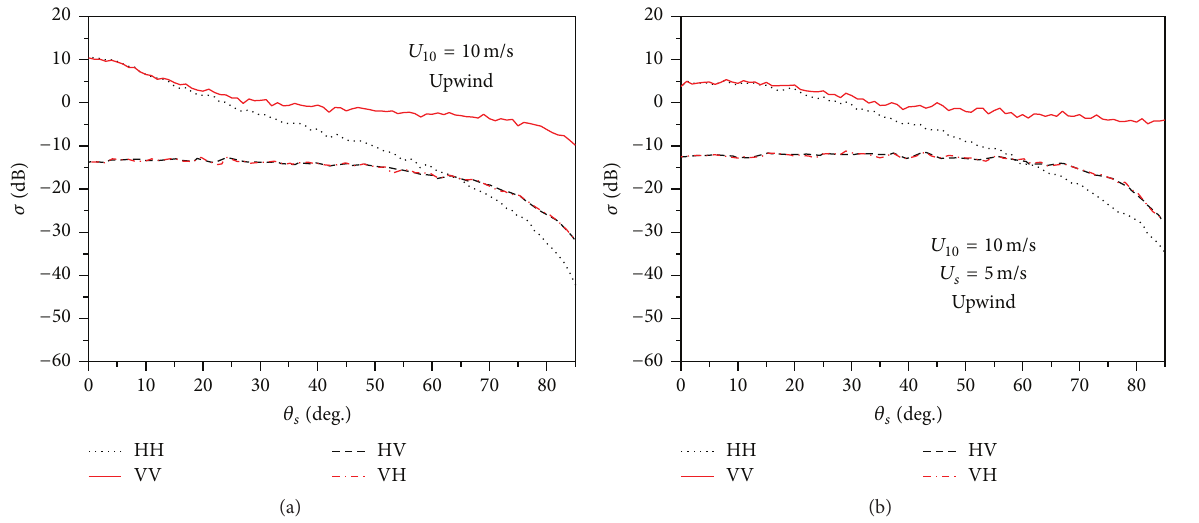
Figure 6: Similar to Figure 5, but for wind speed 𝑈 10 = 10 m/s. (a) Sea surface only and (b) sea surface with wake at ship speed 𝑈 𝑠 = 5